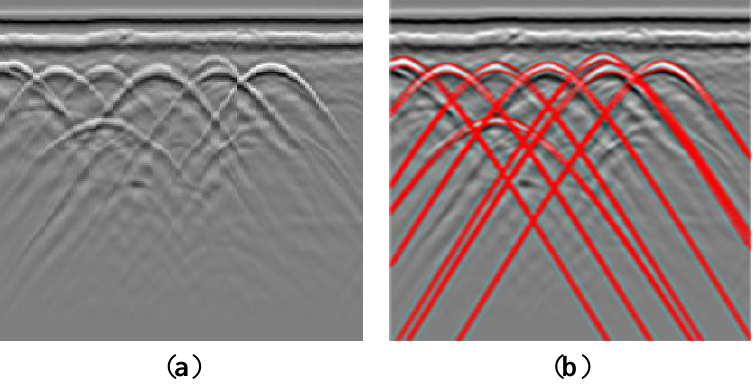
Figure 9. Example of landmine detection results. ( a ) GPR image; ( b ) Processed image with detected patterns. Figure 10. Example of test metal point targets data. ( a ) Real GPR image; ( b ) Processed results with detected patterns.